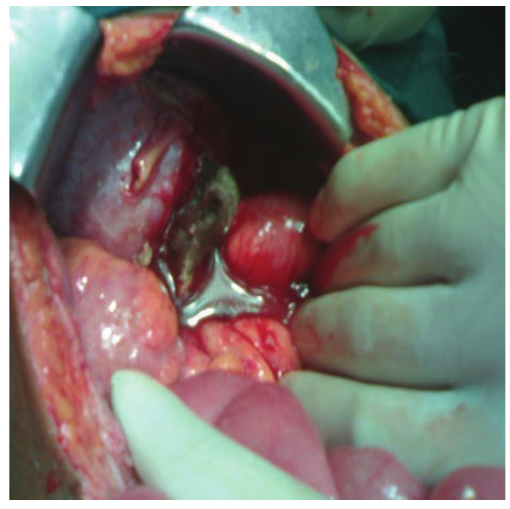
Figure 1: Left ovarian teratoma infiltrating into sigmoid colon.